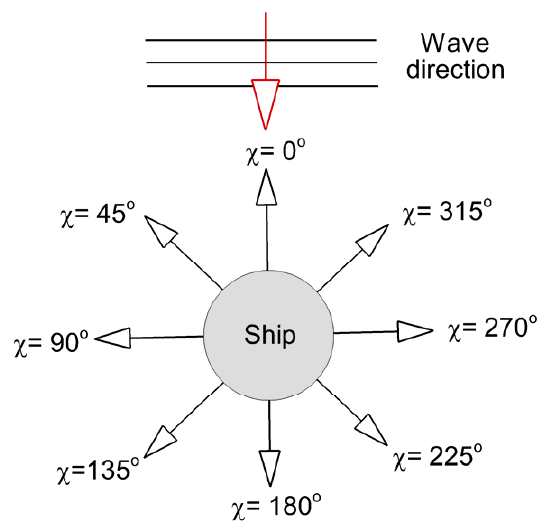
Figure 5. Relative angle between the ship heading and the wave direction.